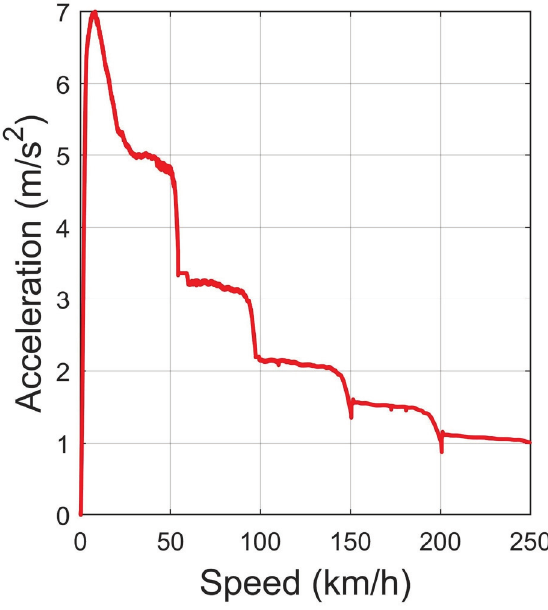
Figure 4. Vehicle acceleration as a function of speed (example of Audi A4 Quattro).